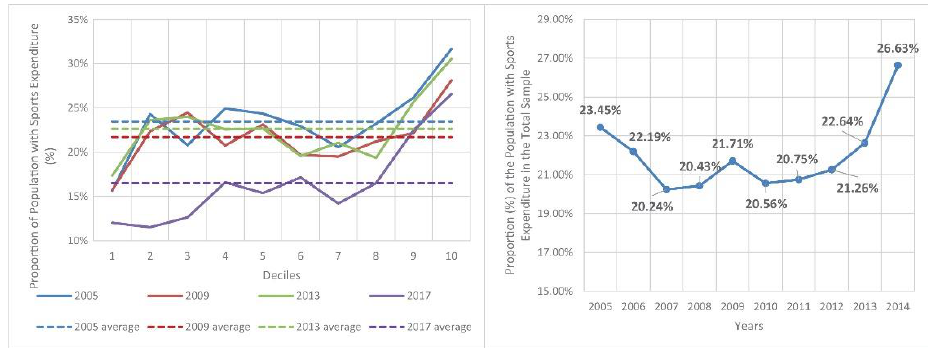
Figure 5. Proportion of population with sports expenditure (%). Source: own calculation (continuous legends: proportions in the given deciles, dotted legends: proportion in the whole populations).